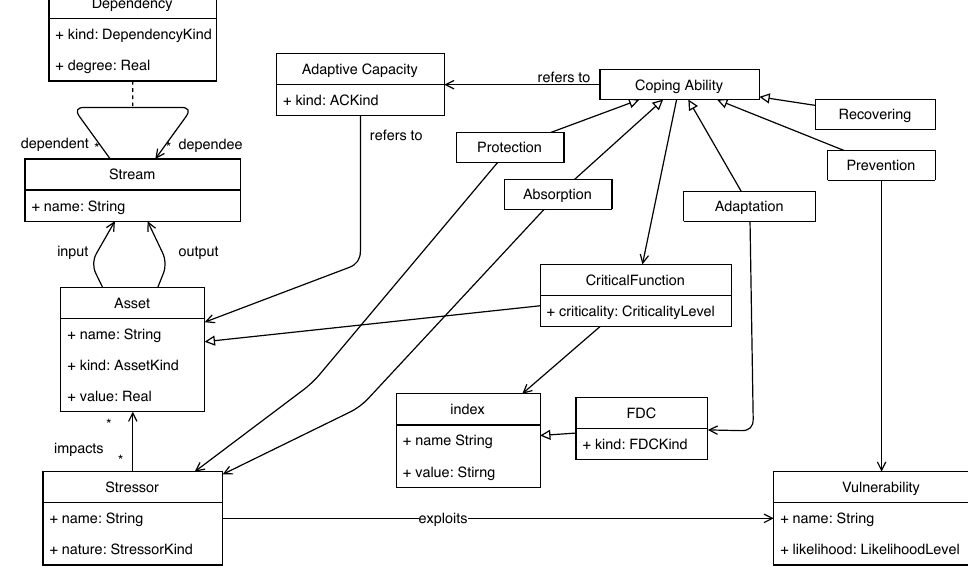
Figure 6. The cyber-resilience domain model—the model elements